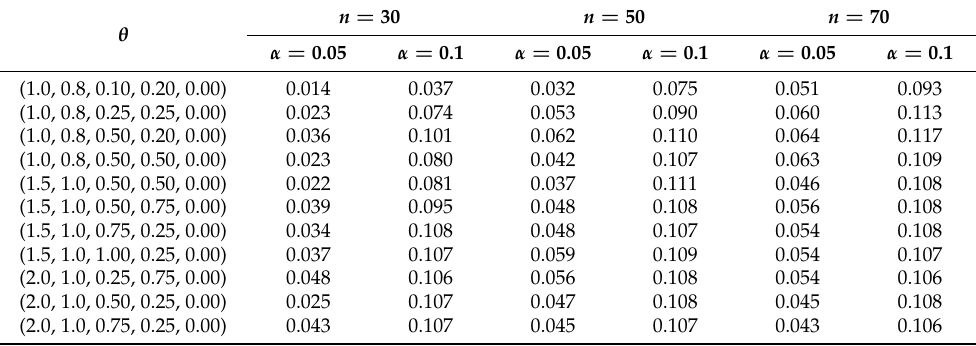
Table 5. Simulation results for the probability of type I error for a 1 = 1 and a 2 = 5.